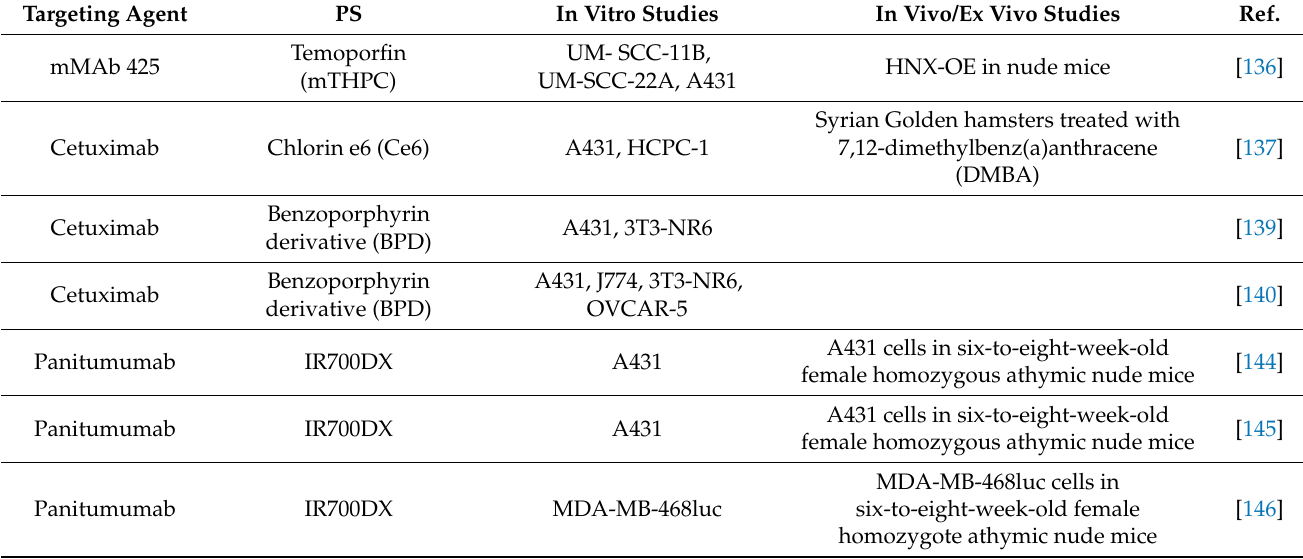
Table 7. EGFR-targeted PDT performed with anti-EGFR monoclonal